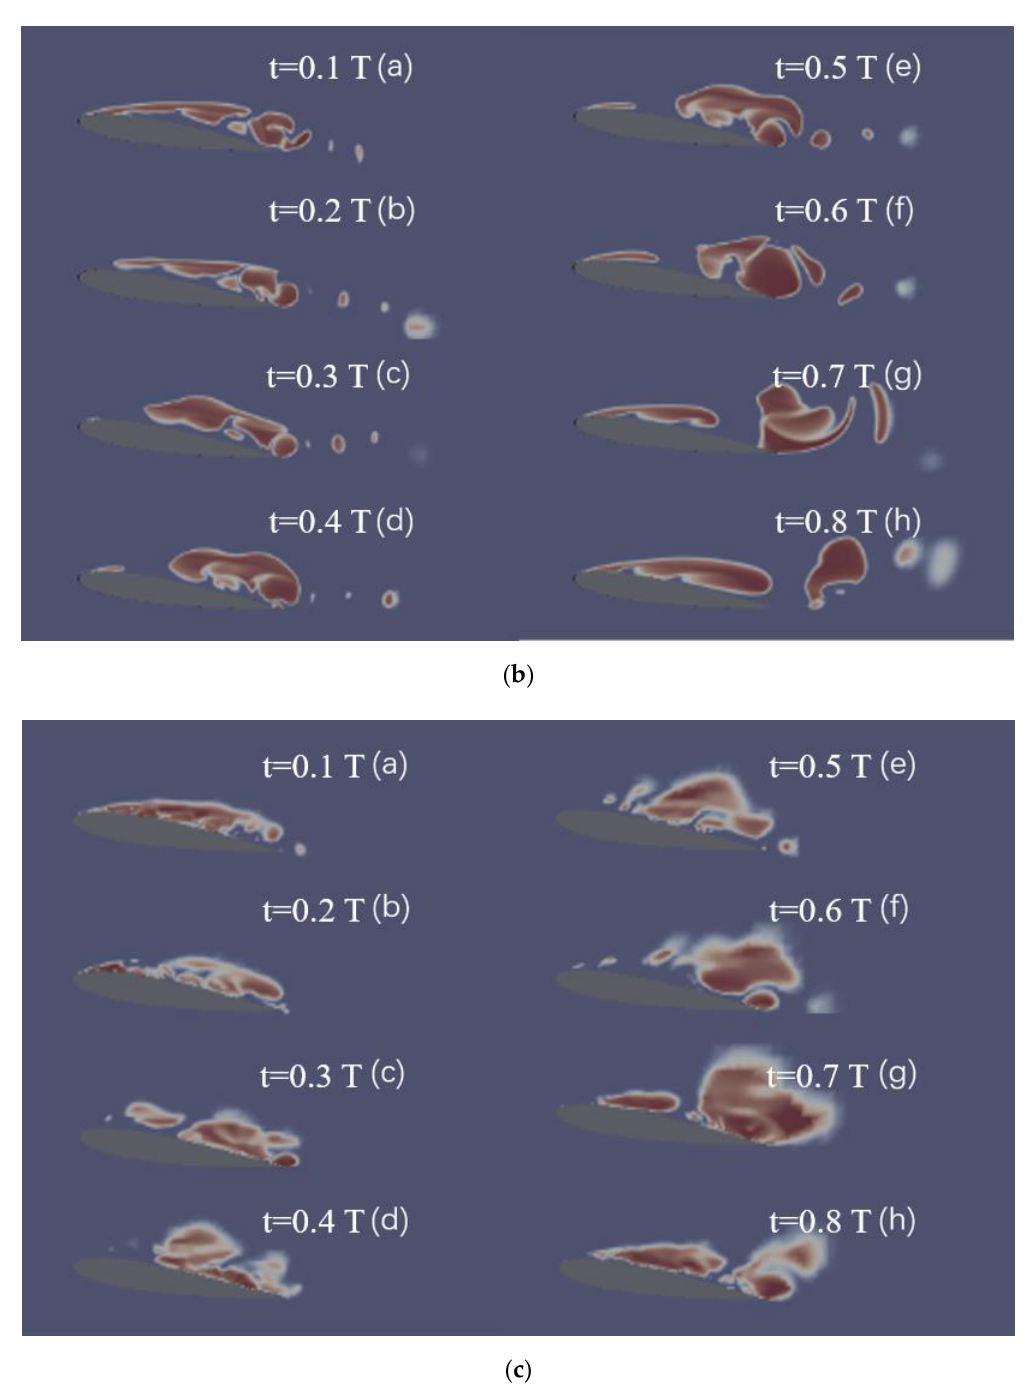
Figure 8. Change of cavitation morphology with different turbulence models at an 8-degree angle of attack. ( a ) Simulation of cavitation with SST k- ω turbulence model. ( b ) Simulation of cavitation with modified SST k- ω turbulence model. ( c ) Simulation of cavitation with the Smagorinsky turbulence model.